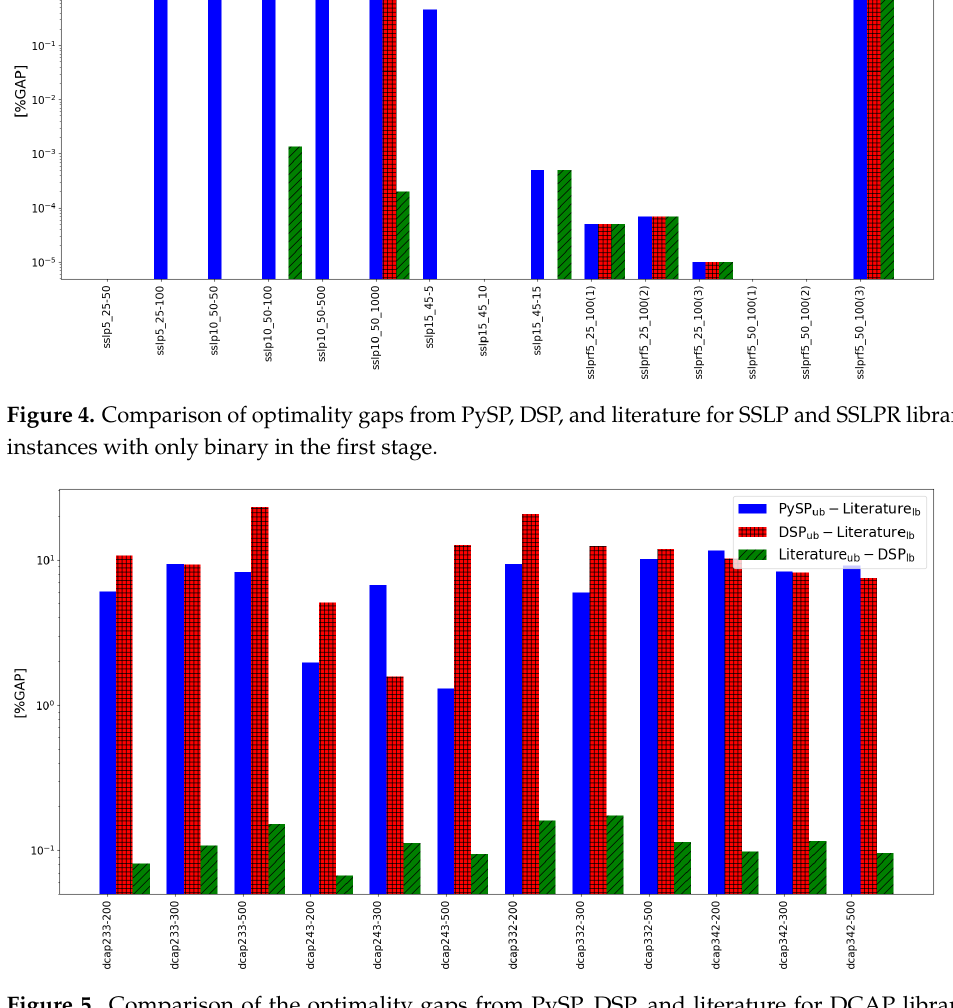
Figure 5. Comparison of the optimality gaps from PySP, DSP, and literature for DCAP library— instances with mixed-integer variables in the first